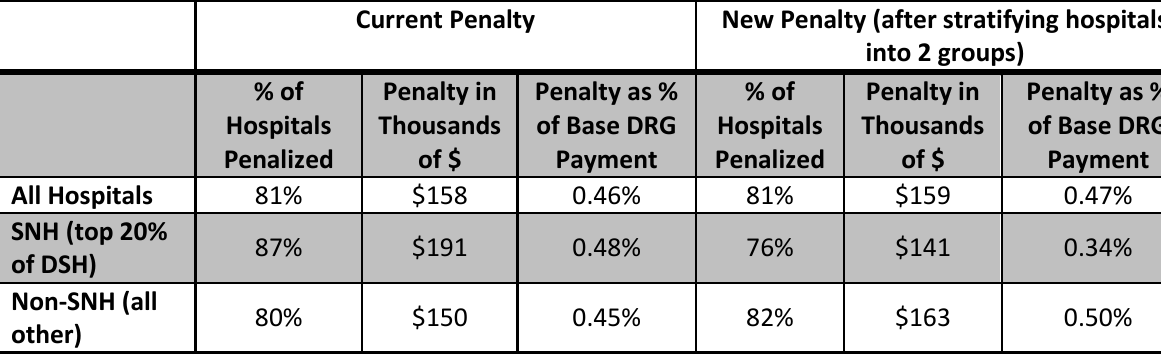
Table 5.9. Results of Stratification by DSH